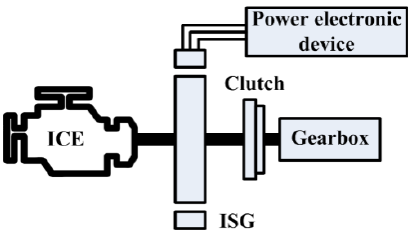
Figure 16. Hybrid powertrain with an integrated starter generator (ISG)